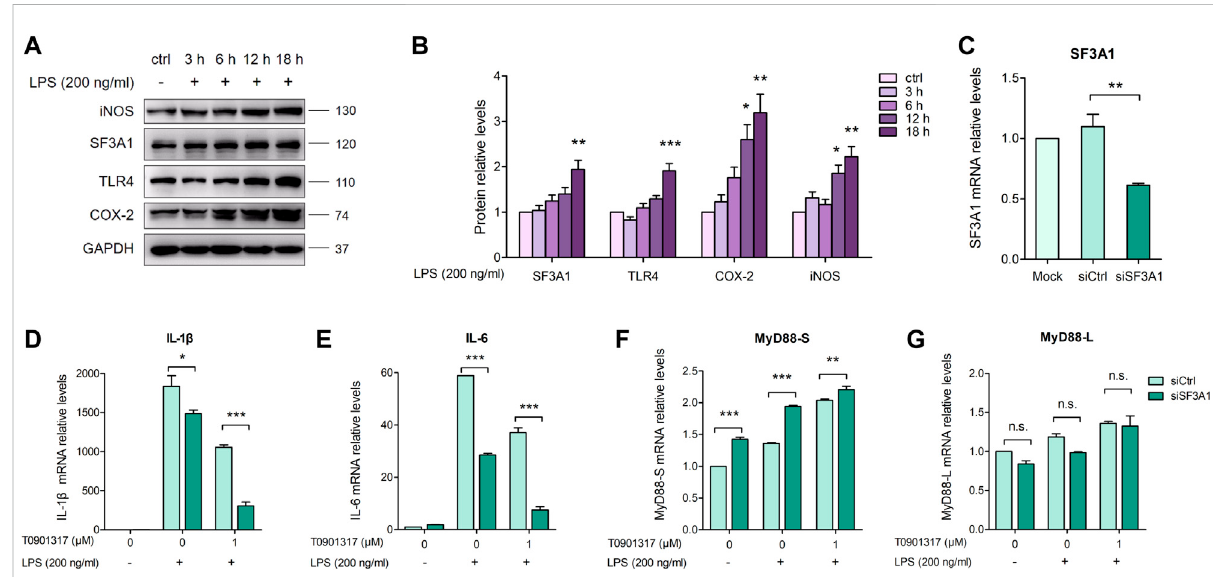
FIGURE 6 Inhibition of SF3A1 synergistically attenuates LPS-induced in fl ammation with T0901317. (A,B) RAW264.7 macrophages were exposed to LPS (200 ng/mL) for 3, 6, 12, or 18 h, then SF3A1, TLR4, iNOS, and COX-2 protein levels were measured by western blot. (C – G) RAW264.7 macrophages were transfected with negative control siRNA or SF3A1 siRNA for 24 h, followed by pretreating with T0901317 (0 or 1 μ M) for 18 h, then stimulated with or without LPS (200 ng/mL) for 3 h. SF3A1, IL-1 β , IL-6, MyD88-S, and MyD88-L isoform mRNA levels were measured by qPCR. All mRNA and protein levels were normalized to GAPDH. Similar results were obtained in three independent experiments. Values are expressed as means ± SEM and were analyzed by one-way ANOVA. * p < 0.05, ** p < 0.01, *** p <